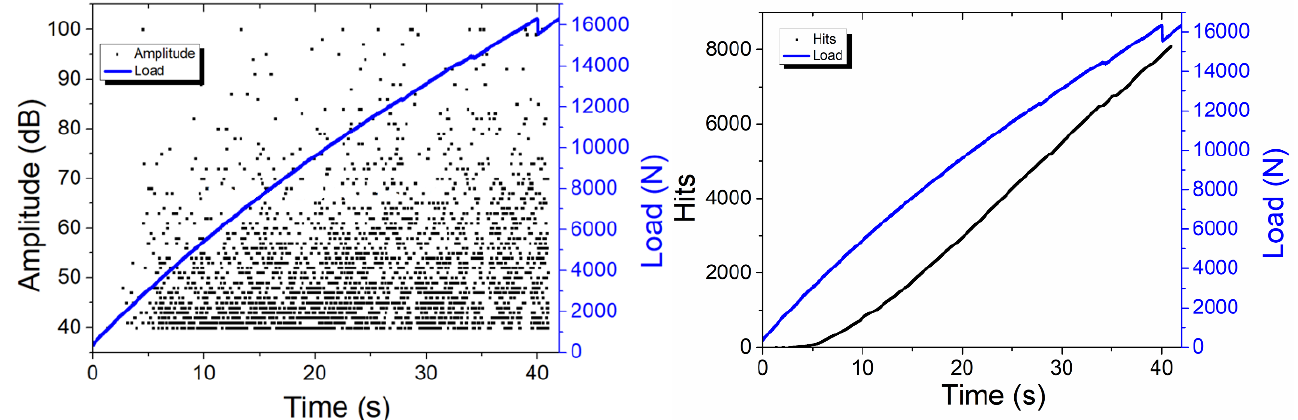
Figure 30. Representative plots of amplitude ( left ) and AE hits ( right ) of repaired lap strap specimens.